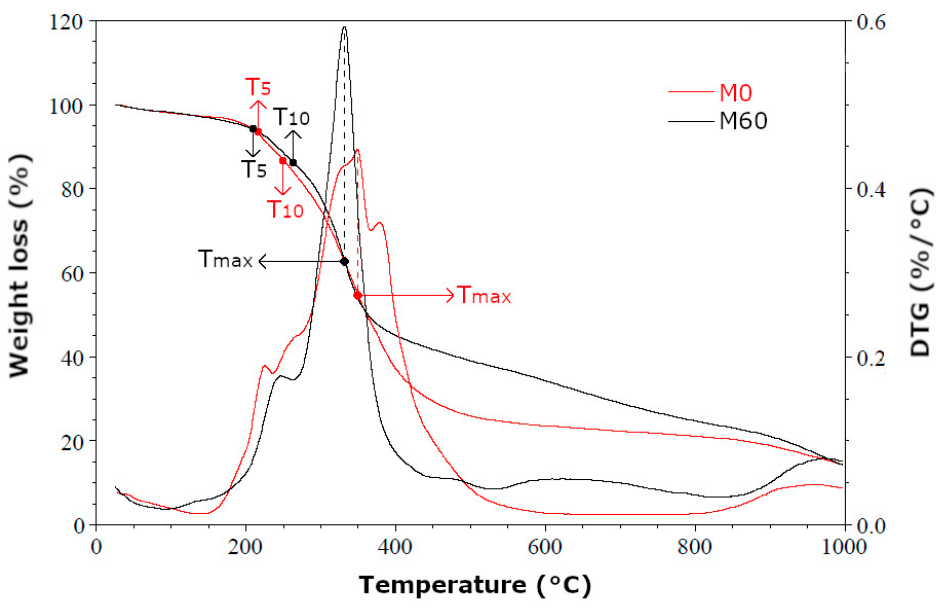
Figure 8. Thermogram of reference foam (M0) and modified foam containing 60 wt.% of bio-filler (M60).